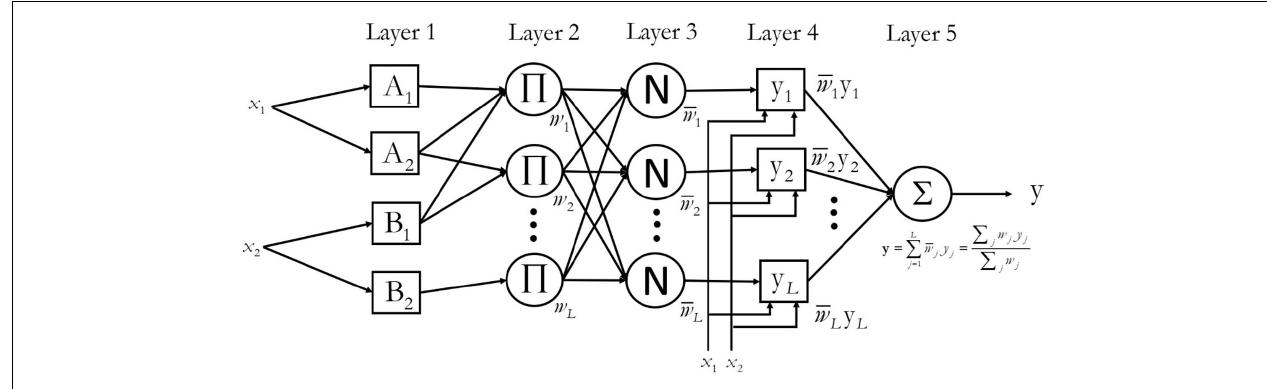
FIGURE 5 | ANFIS architecture.